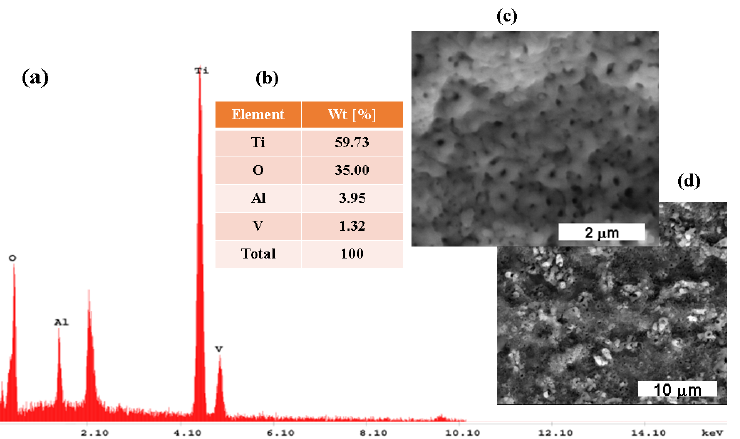
Figure 4. SEM surface micrograph and EDX analysis of the treated Ti6Al4V grade 5 implant alloy electrochemically oxidized at a potential of 200 V for 3 min: ( a ) EDX spectrum; ( b ) EDX elemental analysis; and ( c , d ) SEM surface morphology at different magnifications.